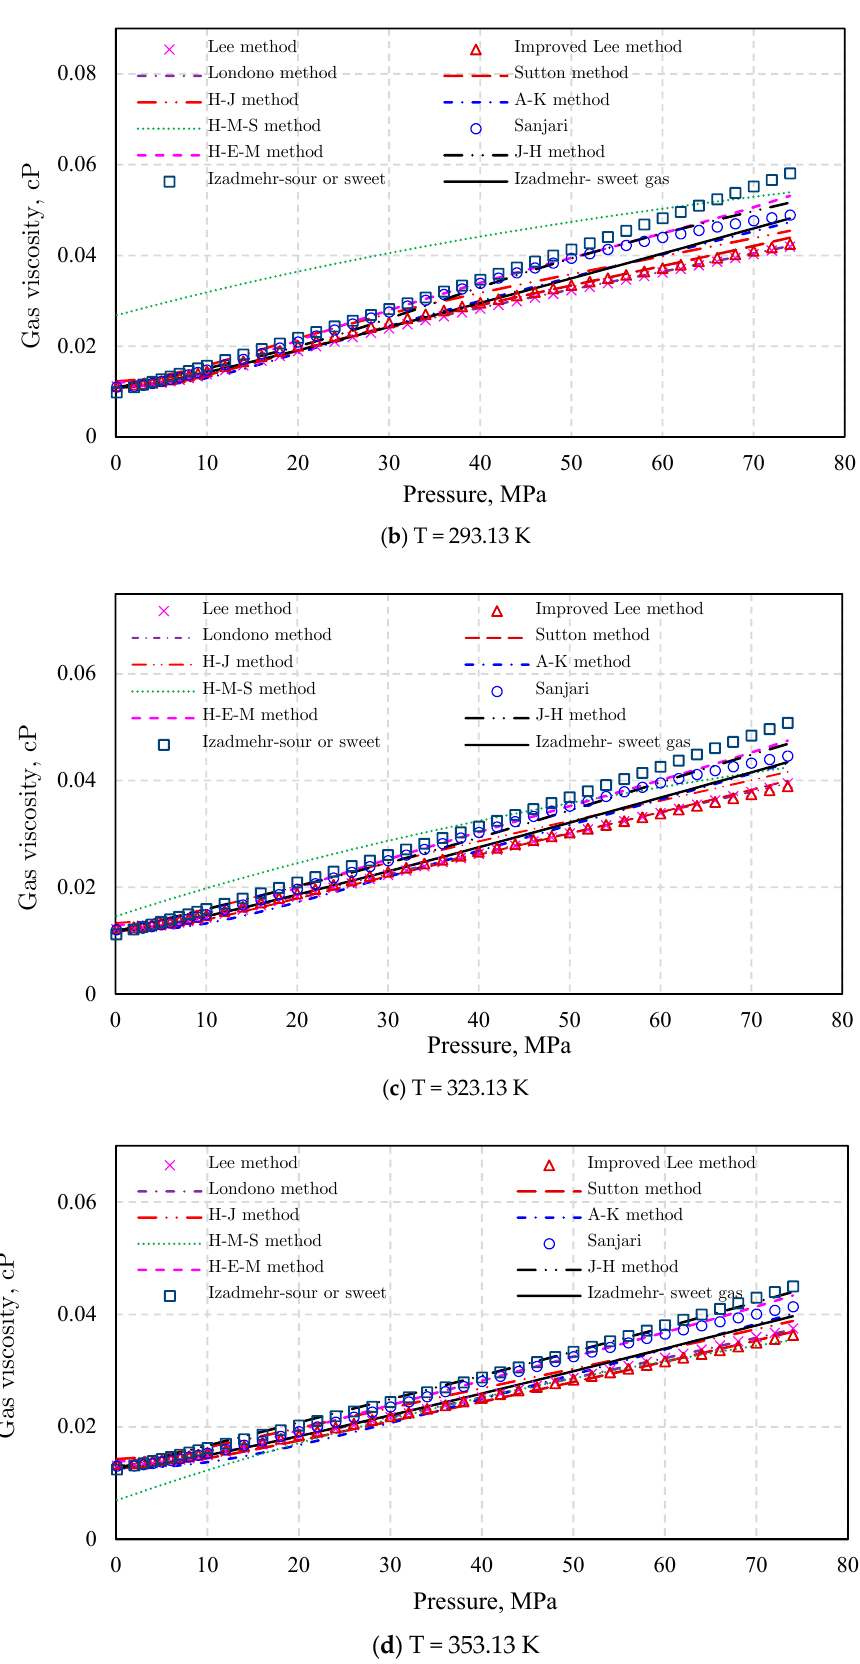
Figure 32. Comparison of gas viscosity results from different models at different temperature conditions. ( a ) 273.13 K. ( b ) 293.13 K. ( c ) 323.13 K. ( d ) 353.13 K.